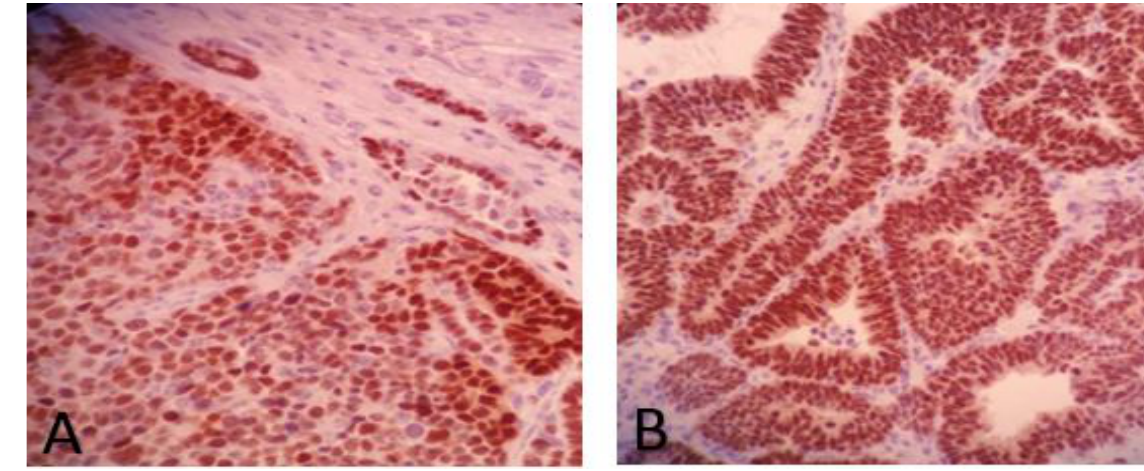
Fig. 2 . PAX8 immunostaining in: A) blastemal component and B) epithelial